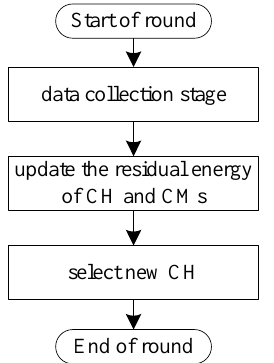
Figure 3. The flowchart for the working process of an SN in a round. CM: cluster